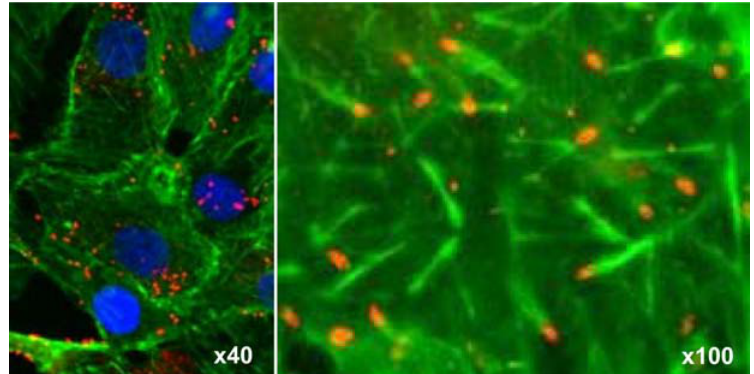
Figure 4. Actin tail phenotype of R.raoultii in Vero cells. The same staining as that described in the Fig. 2 was applied on Vero cells infected for 24 h with R. raoultii (magnifications 40 6 and 100 6 ).